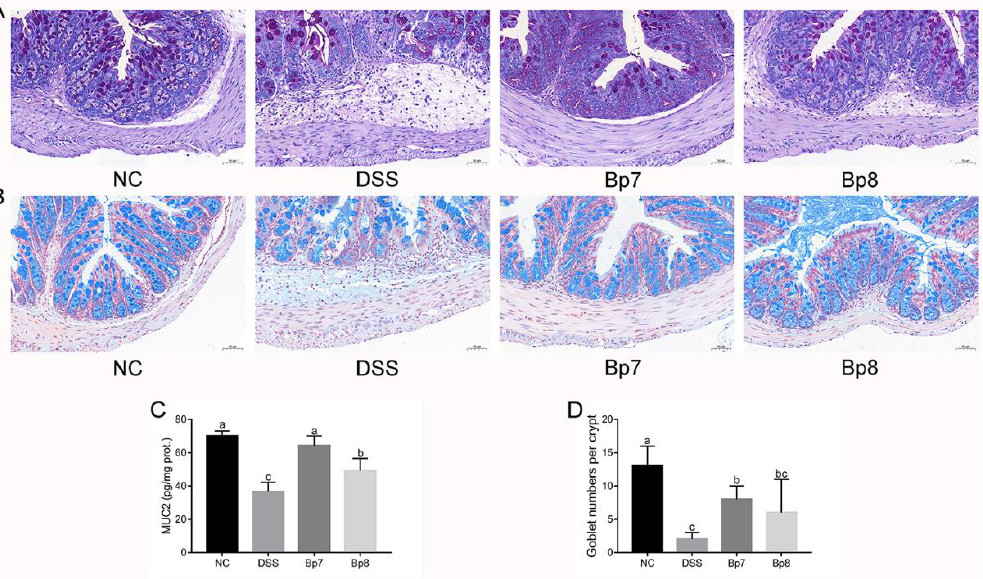
Figure 4. Influence of Bp7 and Bp8 intervention on the foundation barrier. Alcuin blue staining of colon ( A ); PAS staining of colon ( B ); Muc2 concentration in the colon ( n = 8) ( C ); Goblet cell number in the colon ( n = 8) ( D ). The different letters represent significant differences between experimental groups ( p < 0.05).